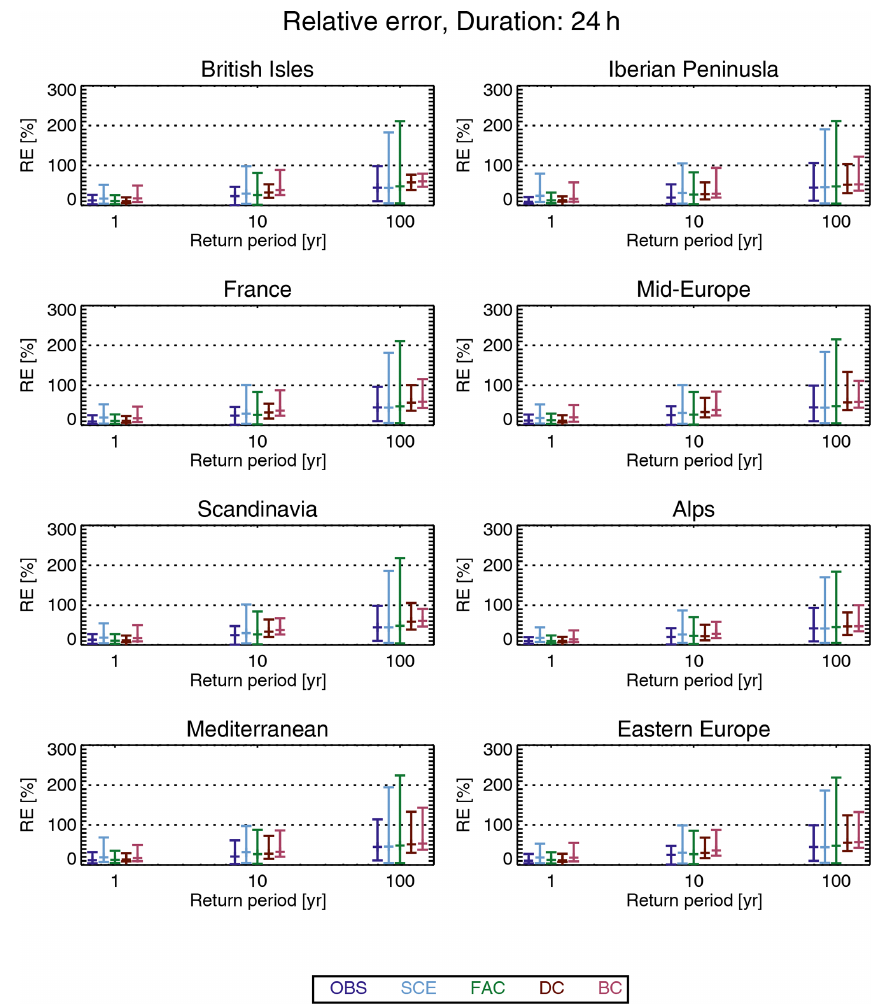
Figure 8. As in Fig. 6 but for a 24h